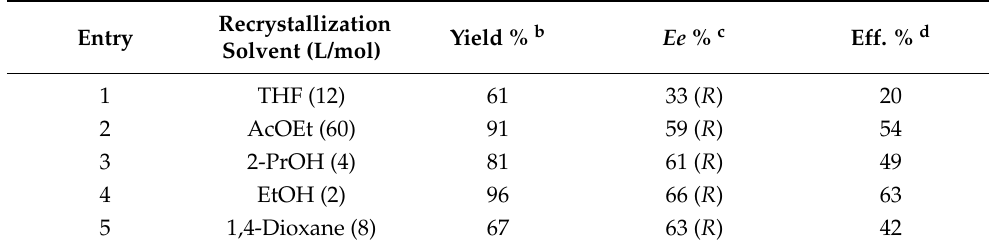
Table 4. Optical resolution of racemic 3-hydroxy-4-phenylbutanoic acid ( rac - 1 ) with cinchonidine a